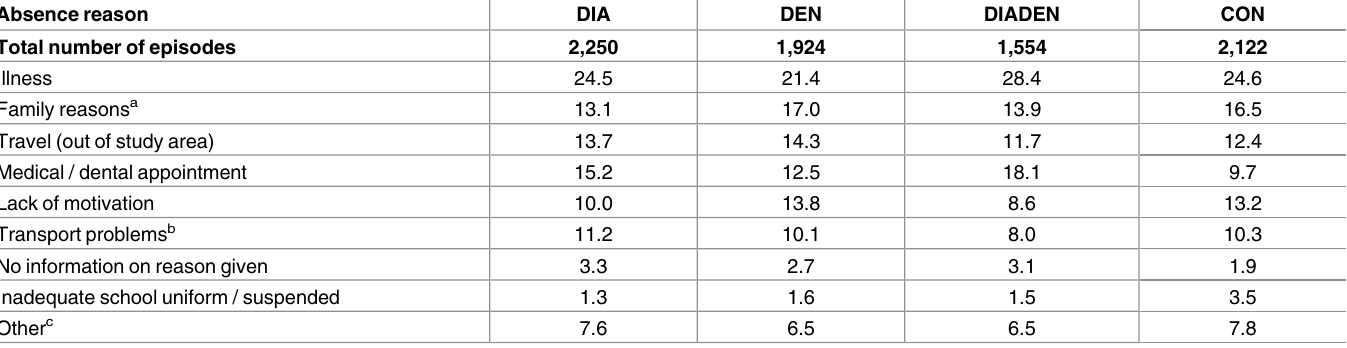
Table 2. Pupil school absence (%) in rural primary schools in four arms receiving either diarrhea (DIA), dengue (DEN), both (DIADEN), or no inter- vention (CON) in Anapoima and La Mesa municipalities, Colombia, 2012–2013. Absence